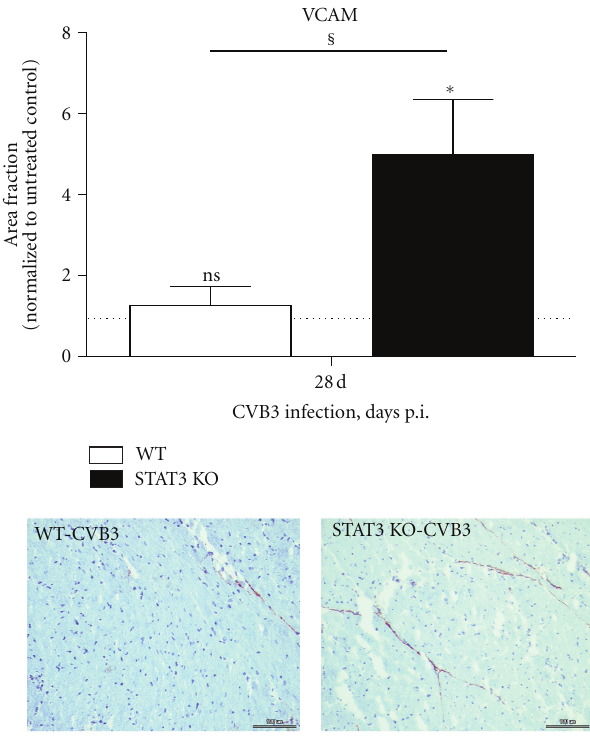
Figure 3: VCAM expression in cardiac tissue of CVB3 infected mice. The expression level was examined at cryosections of control or infected mice. The expression is shown as area fraction and was normalized to the corresponding untreated mice and expressed as x- fold over basal expression. ∗ Data were compared to the expression of the corresponding untreated controls. ∗ P < 0 . 05; § Data between WT and STAT3 KO mice were compared. § P < 0 . 05.